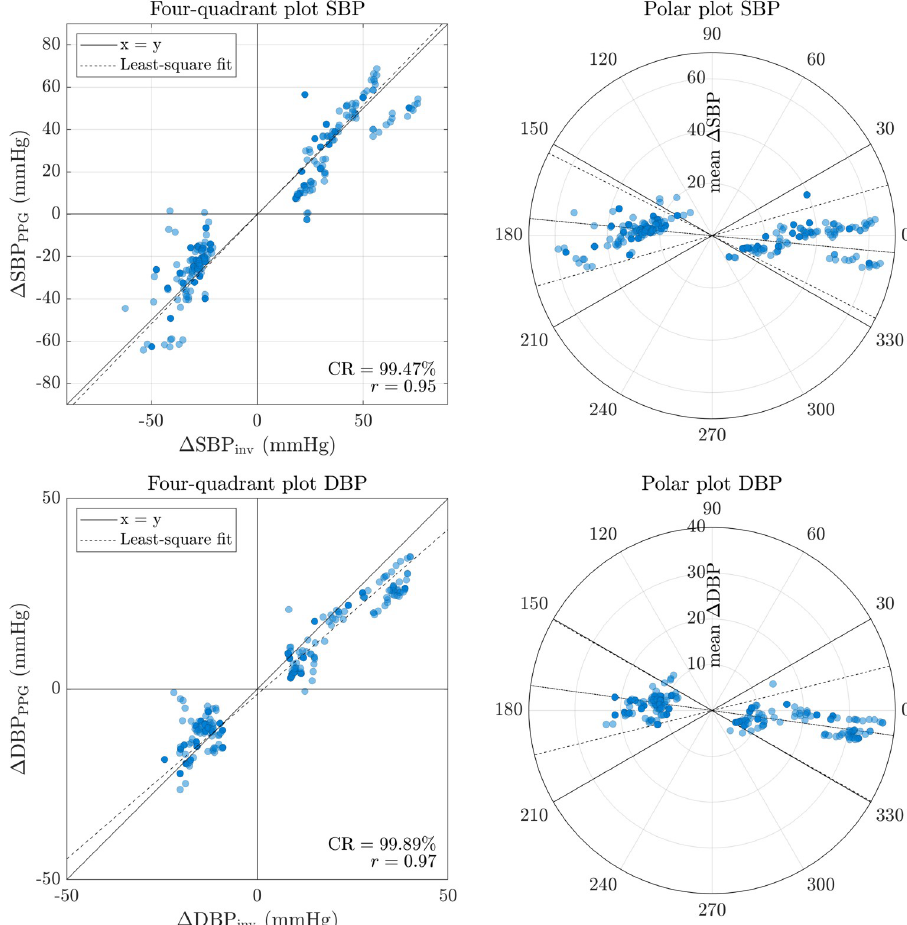
Fig 8. Trending ability. Four-quadrant plots (on the left) and polar plots (on the right) demonstrating the trending ability of PPG-based approach with Lasso regression against the invasive reference for rapid changes in SBP (top) and DBP (bottom) occurring over a time span of 3 min. The solid lines correspond to the ± 30˚ upper radial limits and define the area in which more the 95% of the data points should lie. The angular bias is represented by the dashed- dotted line. And the 95% confidence interval by the dashed